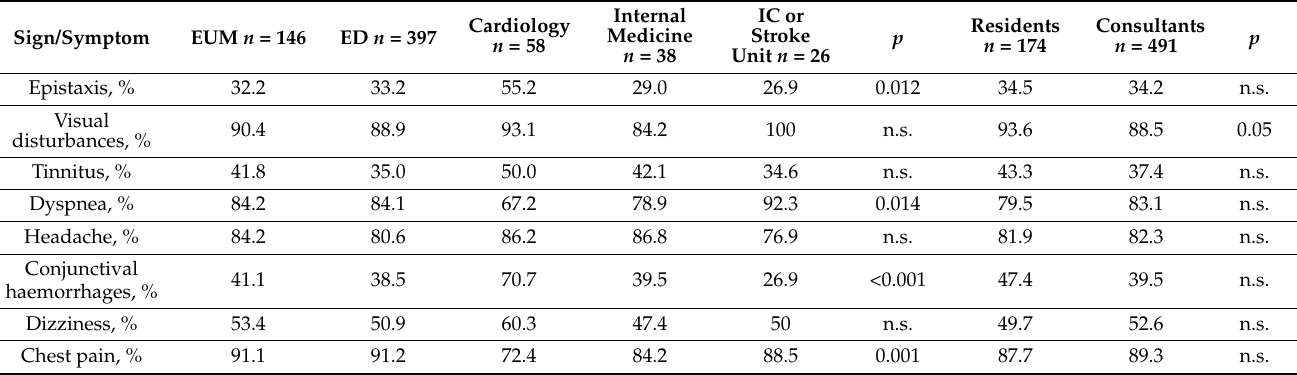
Table 4. Signs and symptoms recognized as suggestive of acute organ damage due to BP increase, by department and qualification